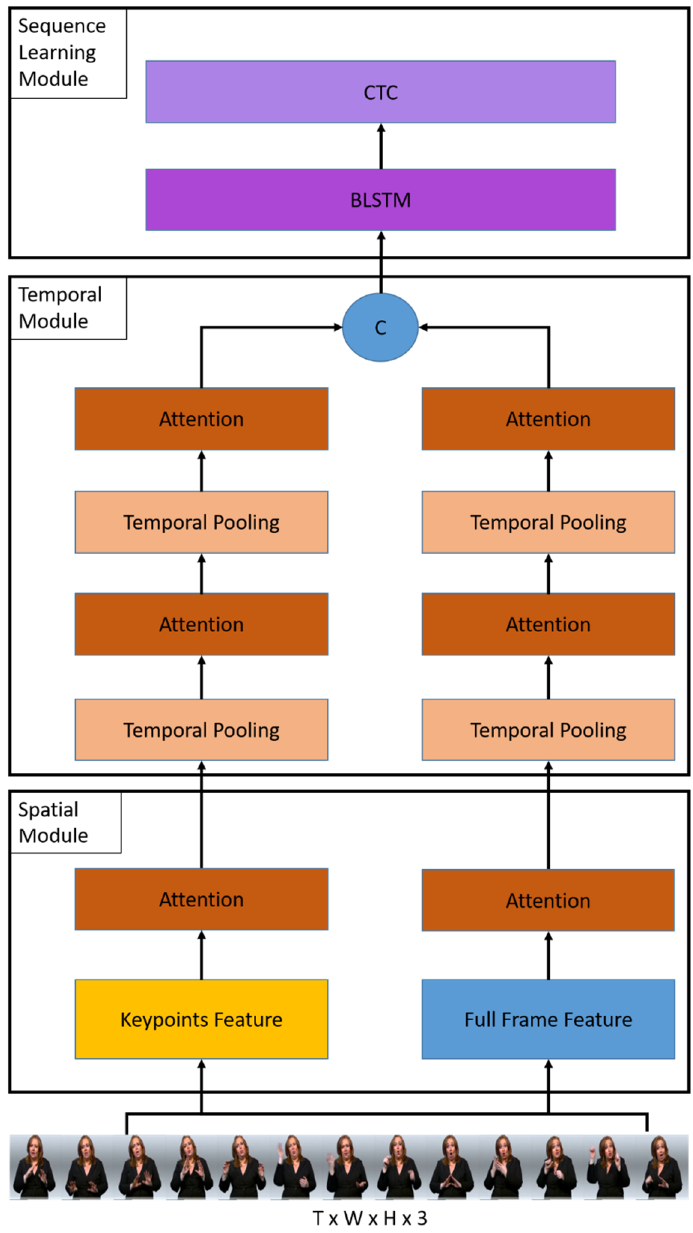
Figure 1. The overall architecture of the proposed method consists of three components: a spatial module, a temporal module, and a sequence learning module. The spatial module first takes the image sequence to extract frame-wise features and then applies the temporal module to extract the temporal features. Then, the temporal features are sent to the sequence learning module to perform word prediction and construct it into a sentence.